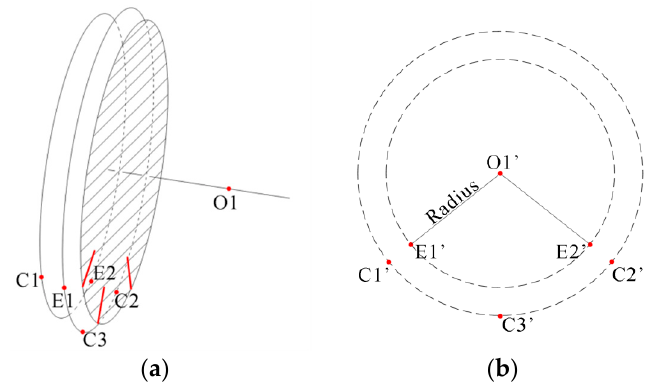
Figure 10. Determine the radius of the wheel. ( a ) The feature points in the 3D coordinate frame; ( b ) the projection of the feature points to the wheel rim plane.